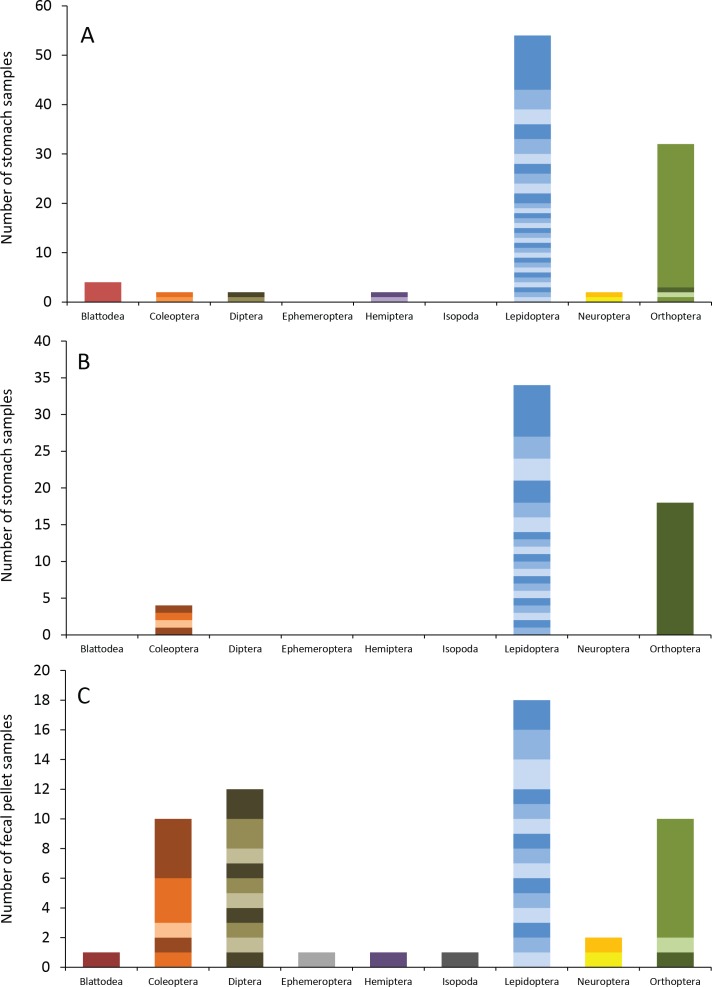
Insect orders (and species within each) found in bat stomachs and fecal pellets.Insect orders found in (A) eastern red bat stomach contents (n = 45 bats collected in 2013 and 2014), (B) hoary bat stomach contents (n = 23 bats collected in 2013 and 2014), and (C) eastern red bat fecal samples (n = 23 pellets collected in 2011–2012) from the Wolf Ridge wind farm. Each band in the bar represents a different insect species. Note that the y-axis differs in each of the figure (A–C).